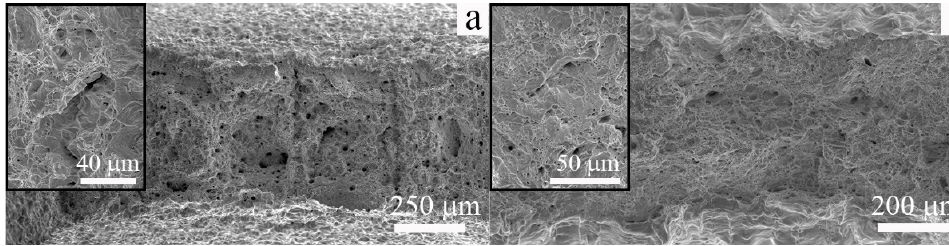
Figure 8. SEM images of fracture surfaces of the low-carbon steel: ( a ) cast and ( b ) EBAM. Specimens were tensile tested to failure at 300 K.